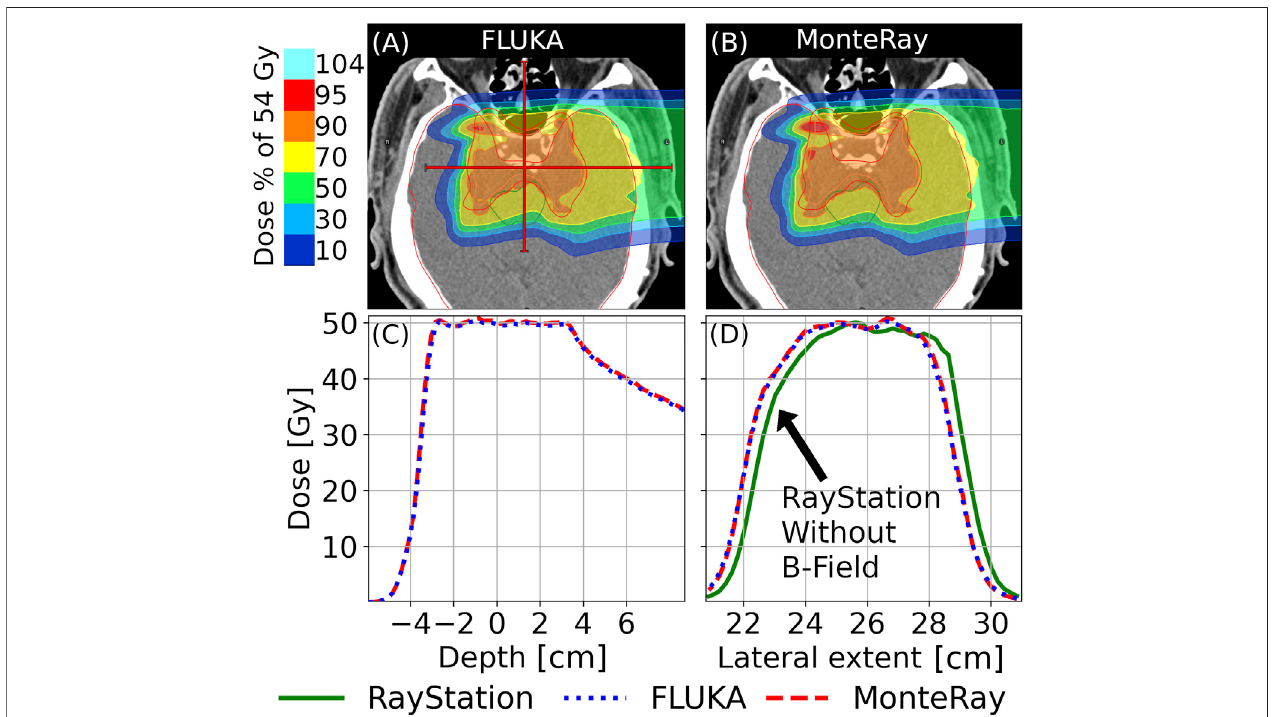
FIGURE 8 | Axial views of calculated doses for the plan described in Section 2.2.4 with an added perpendicular magnetic fi eld of 1 T are shown for (A) FLUKA and (B) MonteRay. In panels (C) and (D) , longitudinal and lateral pro fi les are shown, respectively. Besides the lateral pro fi les obtained from FLUKA and MonteRay, we also show the lateral pro fi le of the RayStation dose calculated without a magnetic fi eld. The locations of the pro fi les relative to the 2D plots are indicated trough red lines in panel (A) . RayStation pro fi les are indicated by a solid green line, FLUKA pro fi les by a dotted blue line and MonteRay pro fi les by a dashed red